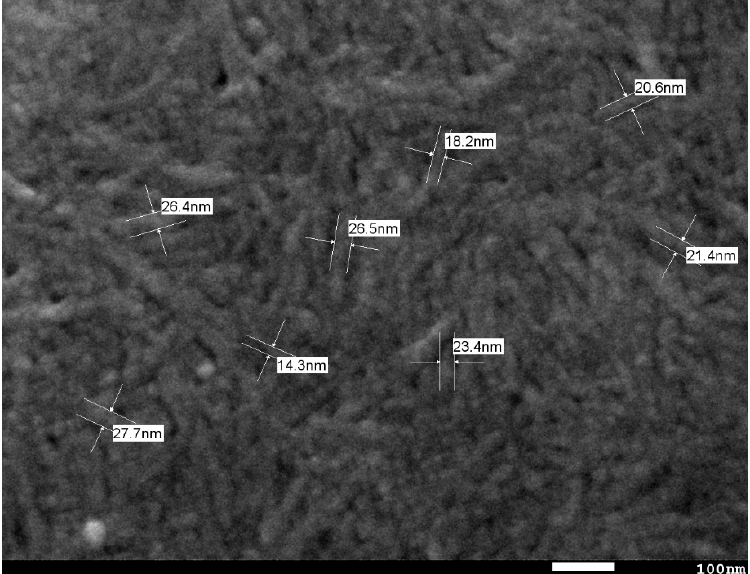
Figure 4. SEM image of the CNF-COOH.